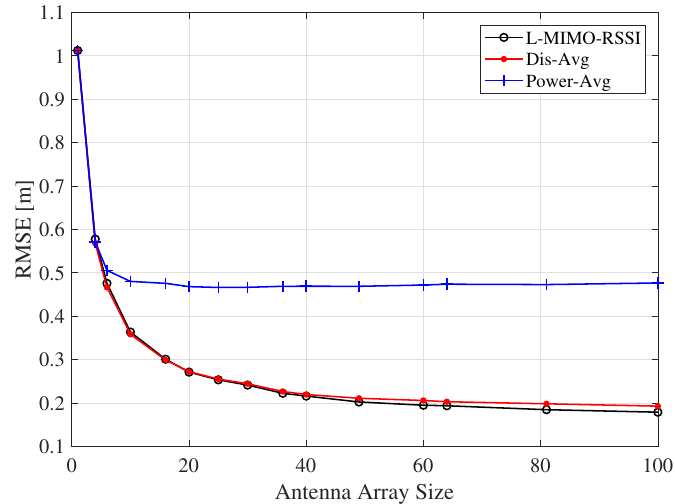
Figure 14. The localization RMSE for the proposed algorithms for different number of antennas on the reader for the LOS environment and the co-polarized antenna